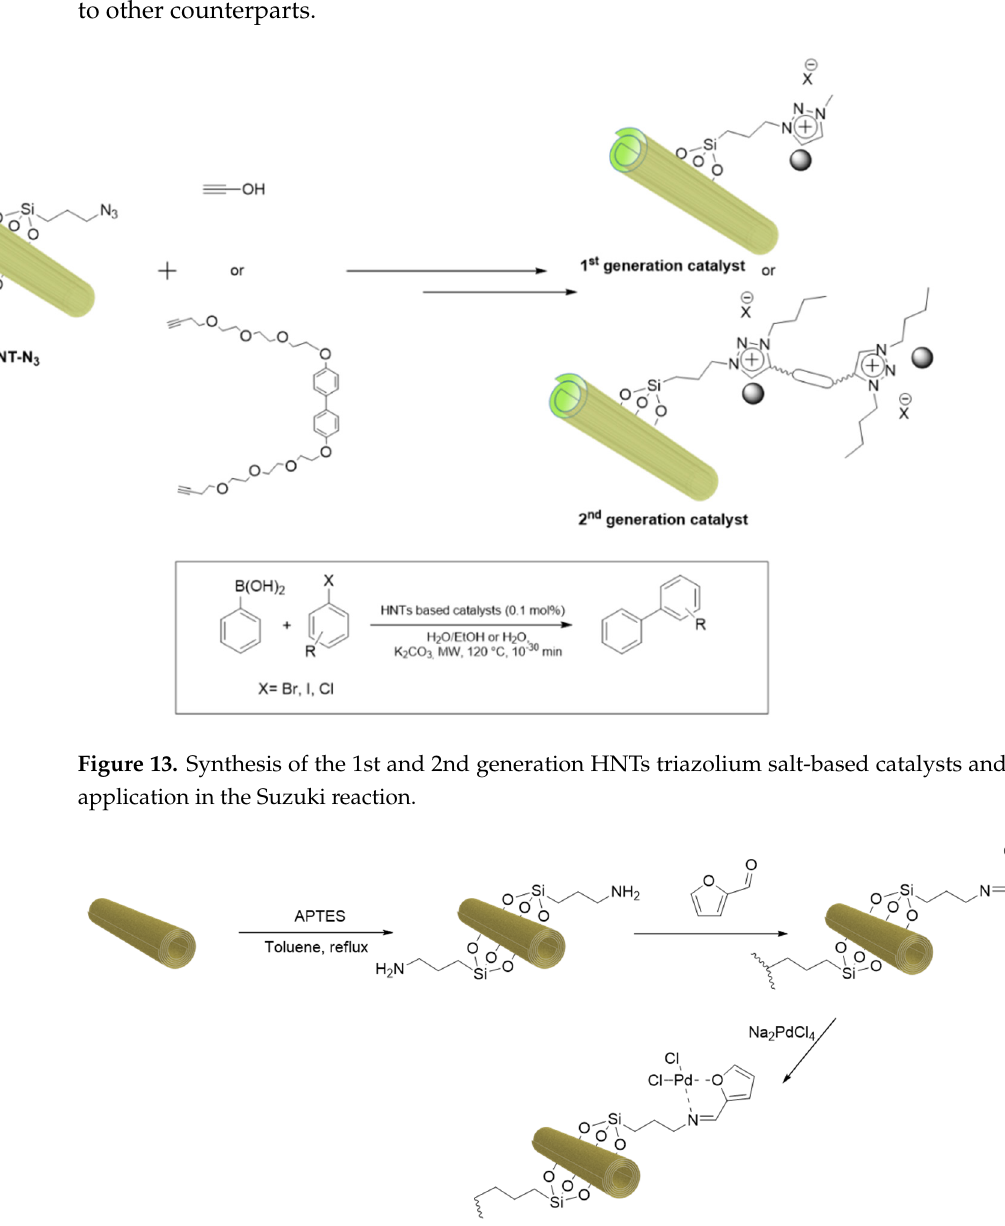
Figure 14. Schematic representation of the synthesis of Schiff base-based HNTs for immobilization of Pd 2+ ions.